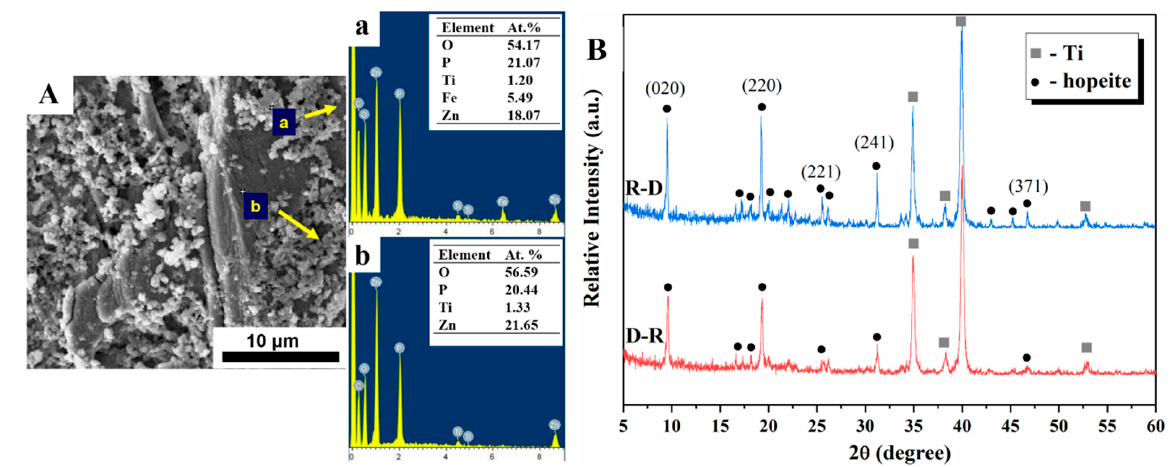
Figure 3. ( A ) EDS results of different regions in the surface of D-S sample, ( B ) XRD patterns of the coatings prepared by different post-processing.